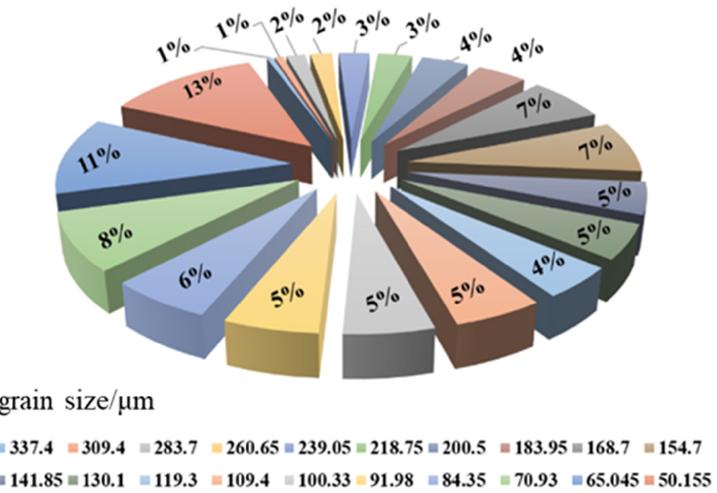
Figure 1. Particle size distribution of hydroxyl terminated polybutadiene (HTPB) propellant.